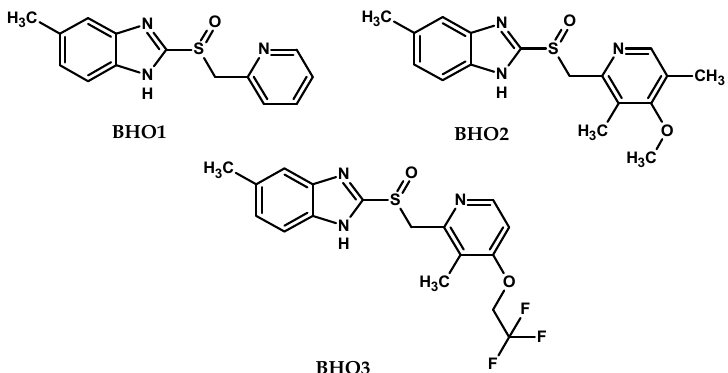
Figure 1. Chemical structure of 2-[(3yridine-2-ylmethyl)sulfinyl]-1 H -benzimidazole derivatives.